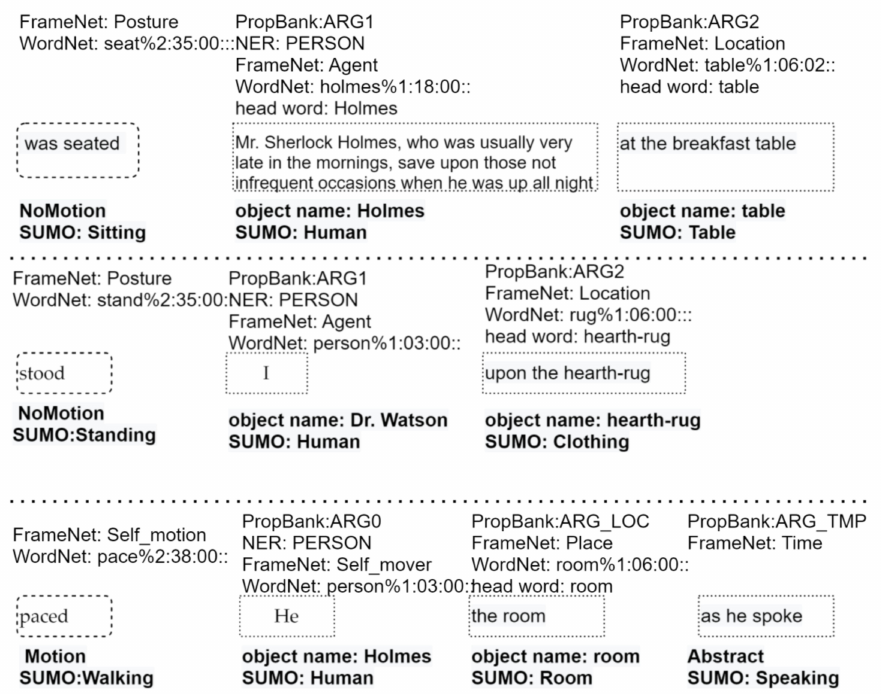
Figure 1. An example of semantic parsing of sentences with an analysis of predicate roles. The labels in bold indicate the object types and object names that are imported into the Drools logical inference engine for reasoning about a scene in the 3D